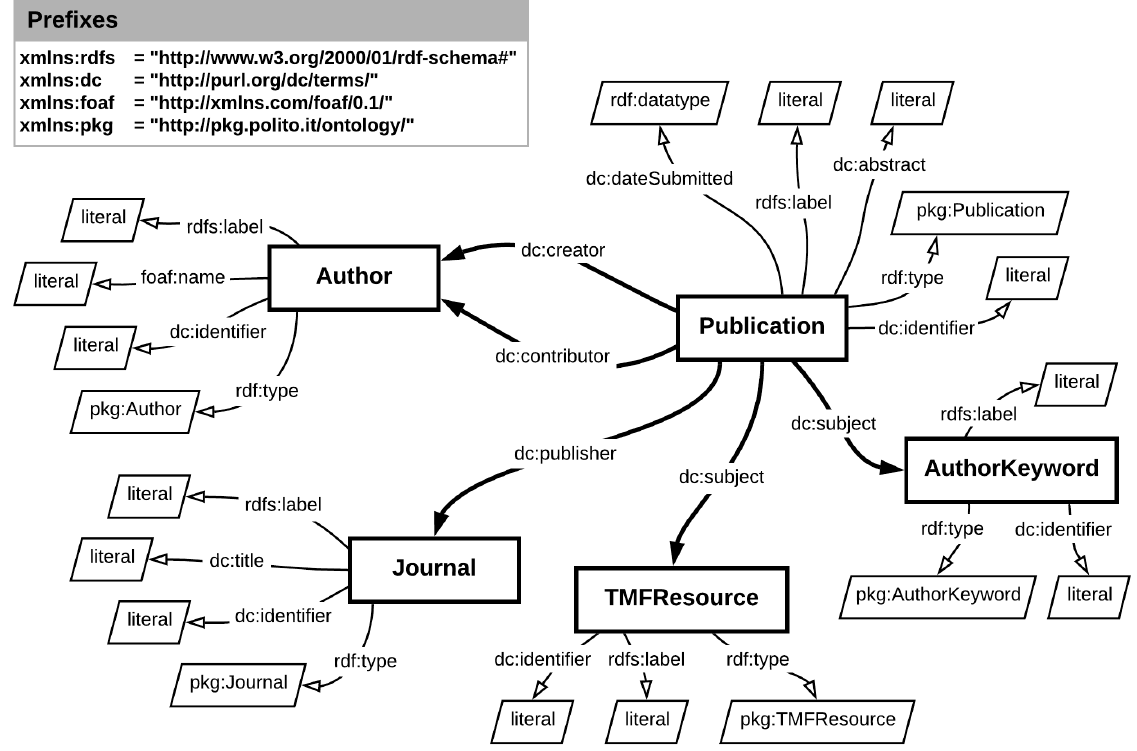
Figure 1. Class schema of the Geranium